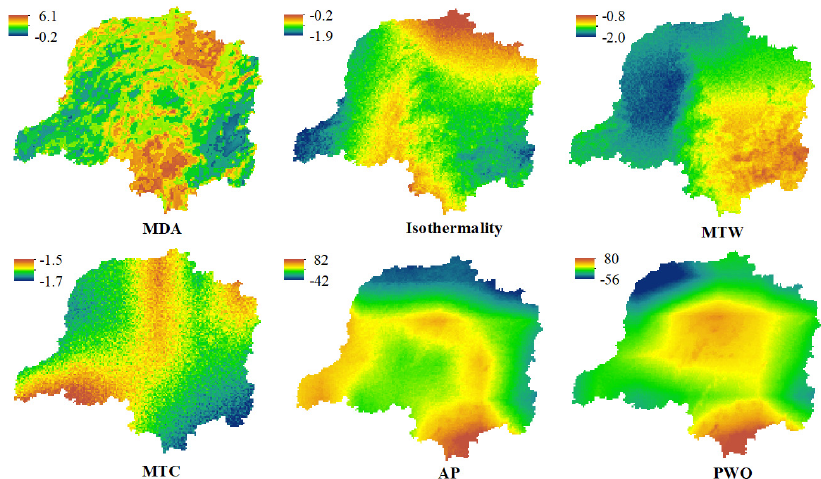
Figure 15. Difference between current bioclimatic variables and future bioclimatic variables in Dongting Lake Basin. Note: The difference is the raster value of current bioclimatic variables minus the raster value of future bioclimatic variables.